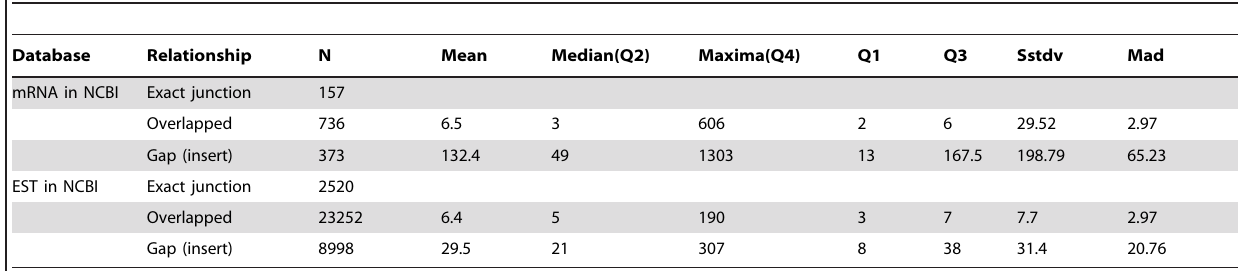
Table 5. Frequencies of three different relationships between two neighboring parnters in chimeric, trimeric and tetrameric RNAs.